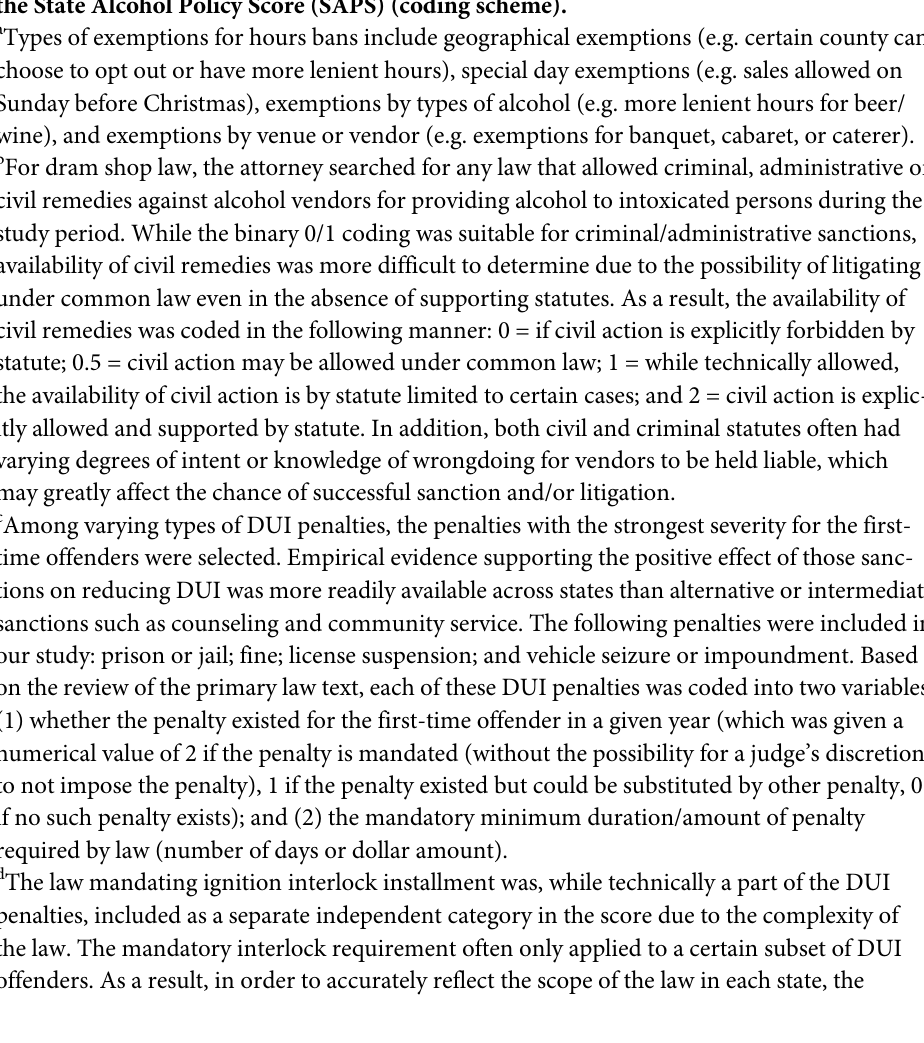
S1 Table. Components and scoring of individual alcohol-related laws and construction of the State Alcohol Policy Score (SAPS) (coding scheme).